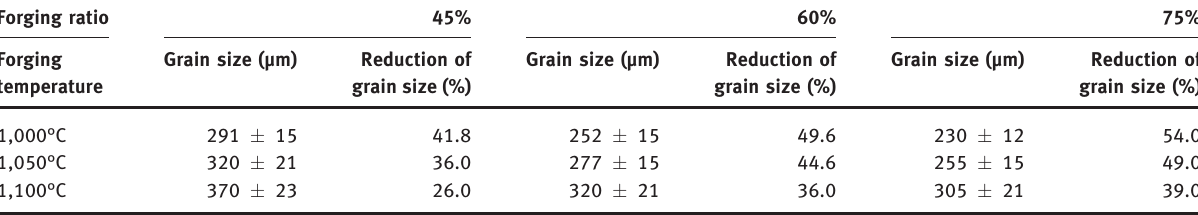
Table 1: The Grain size of forged Ti-7Cu alloy. Forging ratio  % Forging Grain size ( μ temperature